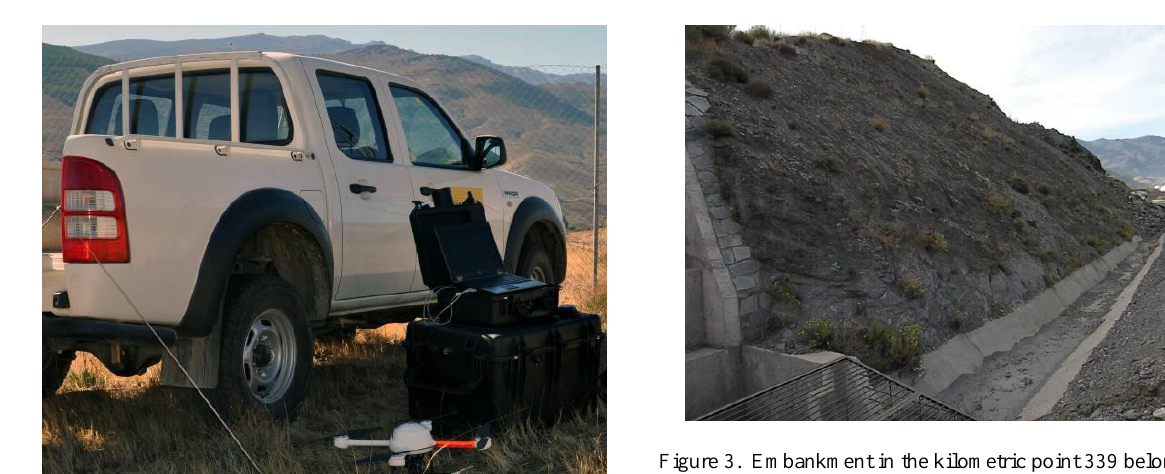
Figure 3. Embankment in the kilometric point 339 belonging to the A92 dual carriageway, Spain